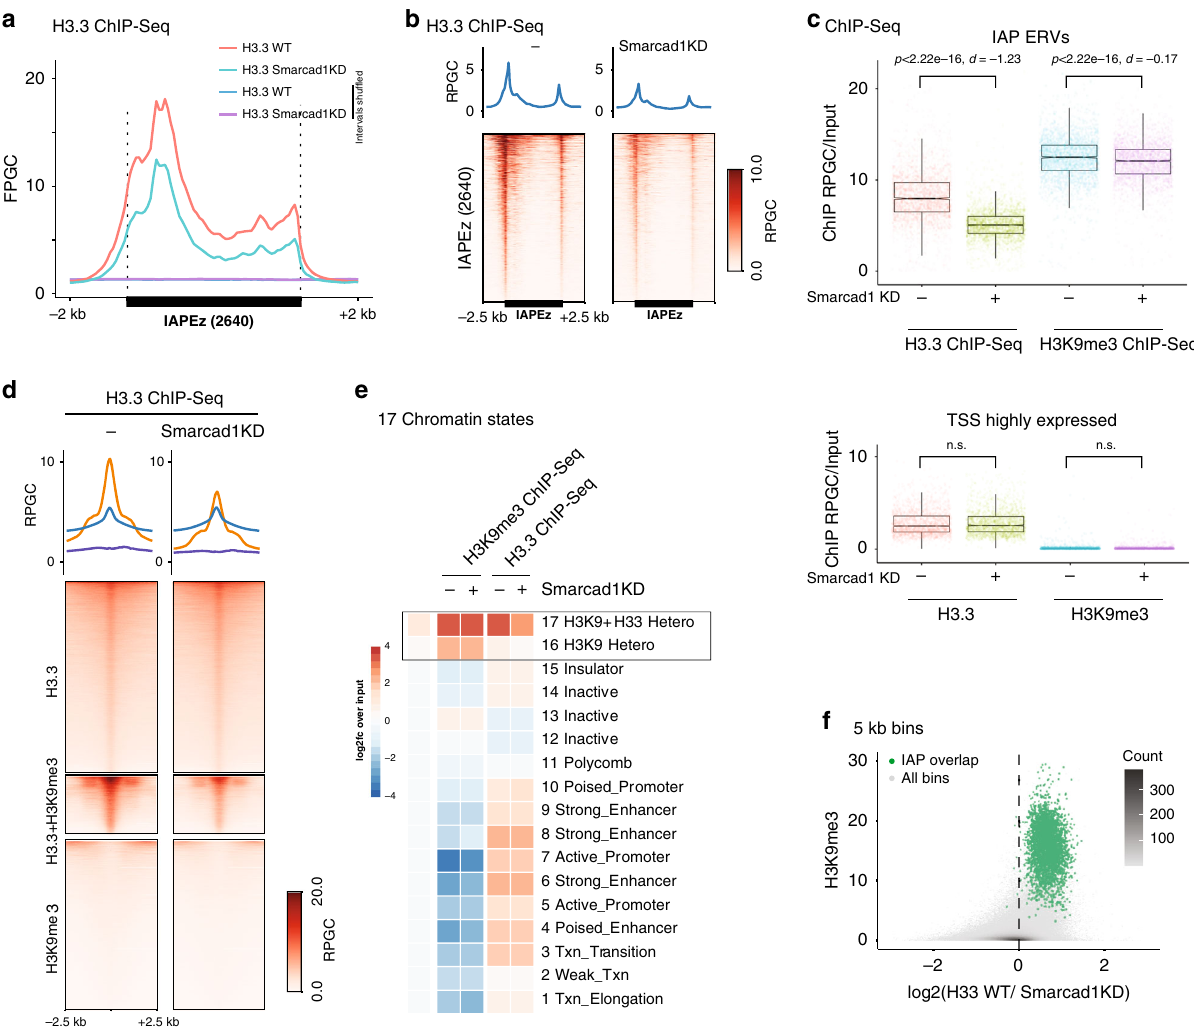
Fig. 6 Smarcad1 drives nucleosome turnover and H3.3 incorporation at interstitial heterochromatin. a Average coverage of H3.3 ChIP-Seq in H3.3 WT mESC, with or without 48 h Smarcad1 knockdown, over IAP ERVs or random control regions. Fragments de fi ned by paired-end reads were piled up and normalized to 1x Genome coverage (Fragments Per Genomic Content, FPGC). b Density heatmaps and average pro fi les of ATAC-Seq signal using only uniquely mappable reads, over 2640 shared IAP ERVs and fl anking regions. c Boxplots showing H3.3 and H3K9me3 ChIP-Seq density at 2640 shared IAP ERVs (top) or 2024 transcription start sites (TSS) of highly transcribed genes (bottom). Tukey-style center (median), box ( fi rst and third quartiles) and whiskers (the maximal 1.5x IQR range). Two-sided Paired T test p value and Cohen ’ s effect size d are given for each pairwise comparison. Data shown from n = 1 biological replicate. Source data are provided as a Source Data fi le. d ChIP-Seq density heatmaps and average pro fi les of H3.3 in H3.3 WT mESC with or without 48 h Smarcad1 knockdown over H3.3-only, H3K9me3-only, and H3.3 + H3K9me3 peaks 21 . e Mean ChIP-Seq read density heatmap showing enrichments of Smarcad1-FLAG 47 , H3K9me3, and H3.3 over 15 ChromHMM states 37 as well as H3K9me3 and H3.3 + H3K9me3 enriched regions 21 . Source data are provided as a Source data fi le. f Density scatter plot of 5 kb bins, showing H3K9me3 level versus log2-fold change in H3.3 enrichment upon Smarcad1 knockdown. Bins overlapping with IAP ERVs are drawn in green. Source data are provided as a Source data fi